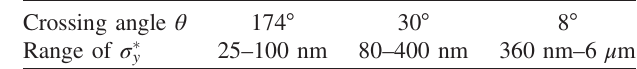
) vs BPM number before target